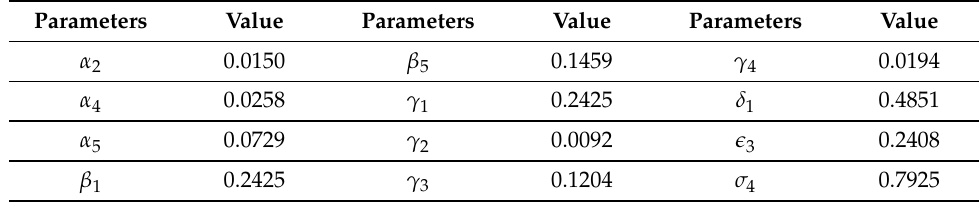
Table 2. The stoichiometric coefficients of the reaction